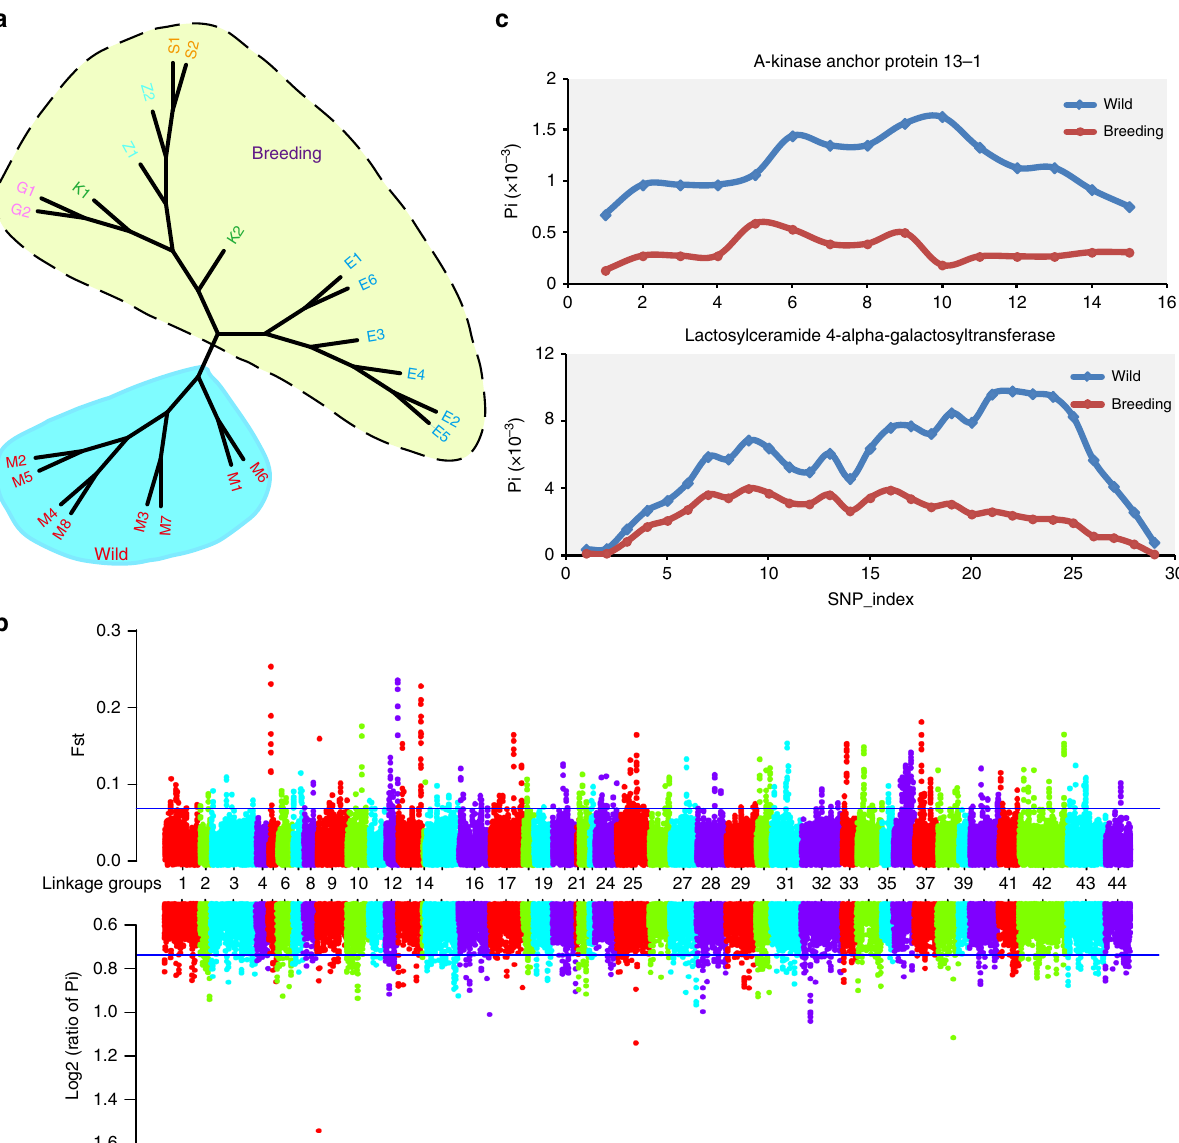
Fig. 6 Genetic diversity and selective sweep analyses in L. vannamei . a The phylogenetic tree of wild (blue) and breeding shrimp (yellow) constructed using whole-genome SNPs. M1 − M8 represent the wild shrimp collected from Mexico, E1 – E6 represent the breeding shrimp collected from Ecuador, K1 and K2 represent the Kehai No.1 variety from China, G1 and G2 represent Guihai No.1 variety in China, S1 and S2 represent Shrimp Improvement broodstock in USA, Z1 and Z2 represent Charoen Pokphand broodstock in Thailand. b Genome-wide view of differentiation ( F ST ) and reduction in diversity ( π wild / π breeding ) statistics associated with the wild and breeding shrimp. The blue line indicates the top 1% of rank level values for empirical percentiles. c The genetic diversity value θπ in wild and breeding population for the genes encoding A-kinase anchor protein 13-1 (AKAP13-1) and Lactosylceramide 4-alpha- galactosyltransferase (A4GALT). A sliding-window approach (2 Kb windows with 400 bp increments) was used to calculate θπ of every window for each gene, and the SNP-index indicates the sliding-window of each